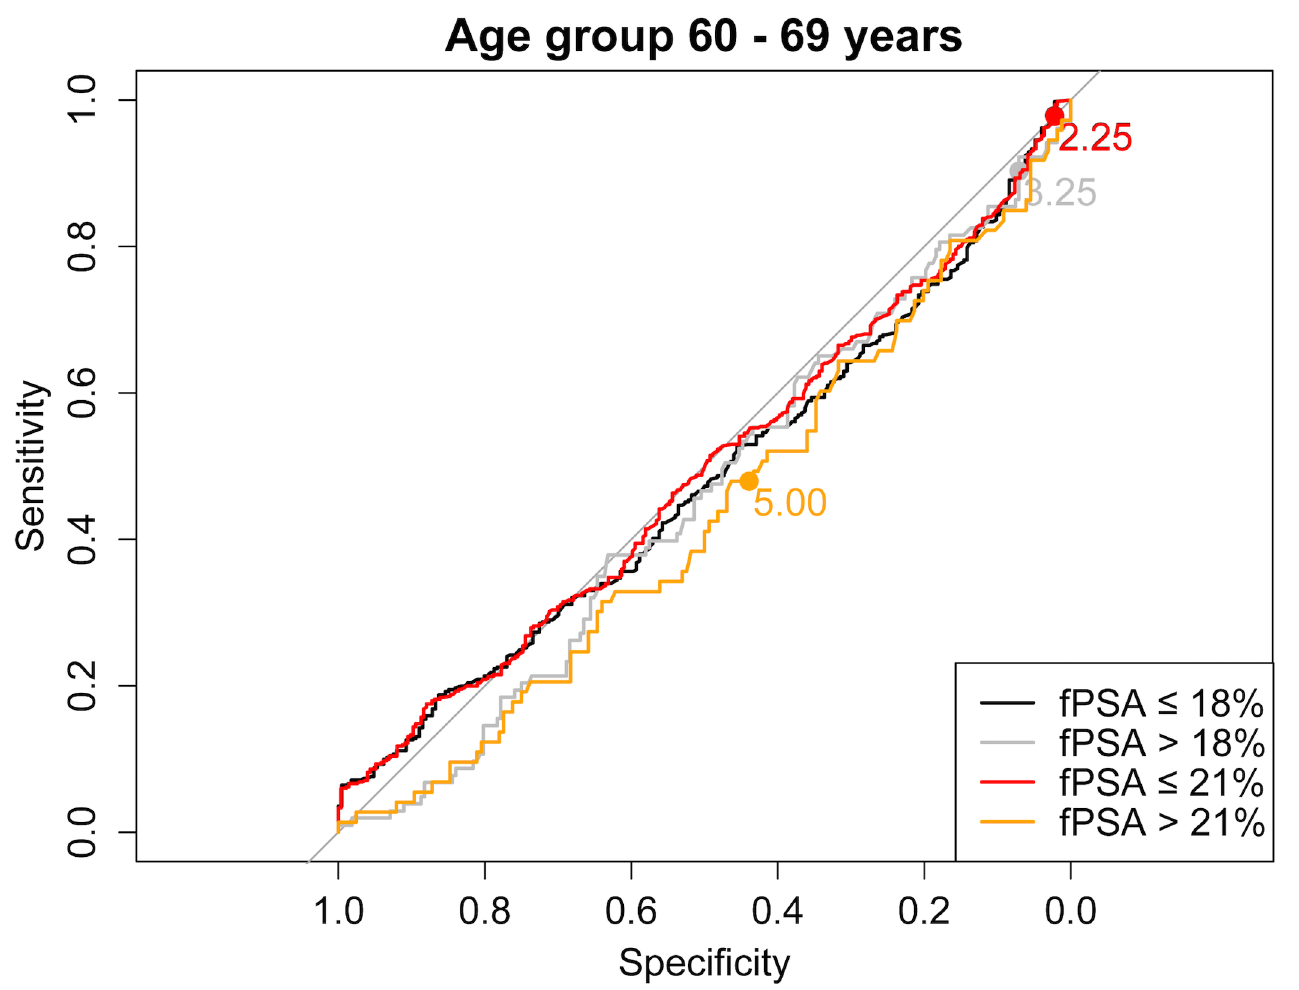
Fig 3. ROC curve for the age group 60 – 69 years stratified for fPSA values (cid:1) 18% vs. > 18% and (cid:1) 21% vs. > 21%, respectively.